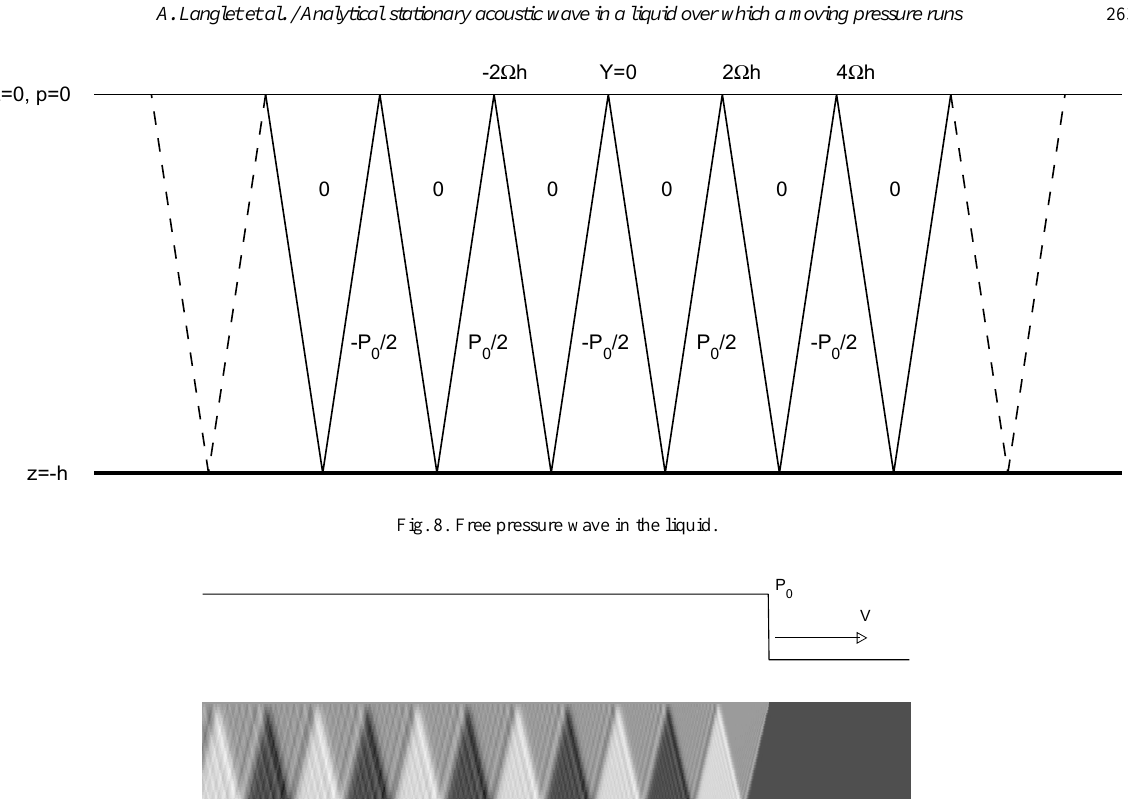
Fig. 9. Acoustic pressure in a strip of liquid loaded by a supersonic quasi-stationary pressure step (height: 0.05 m, length: 1 m, V = 2000